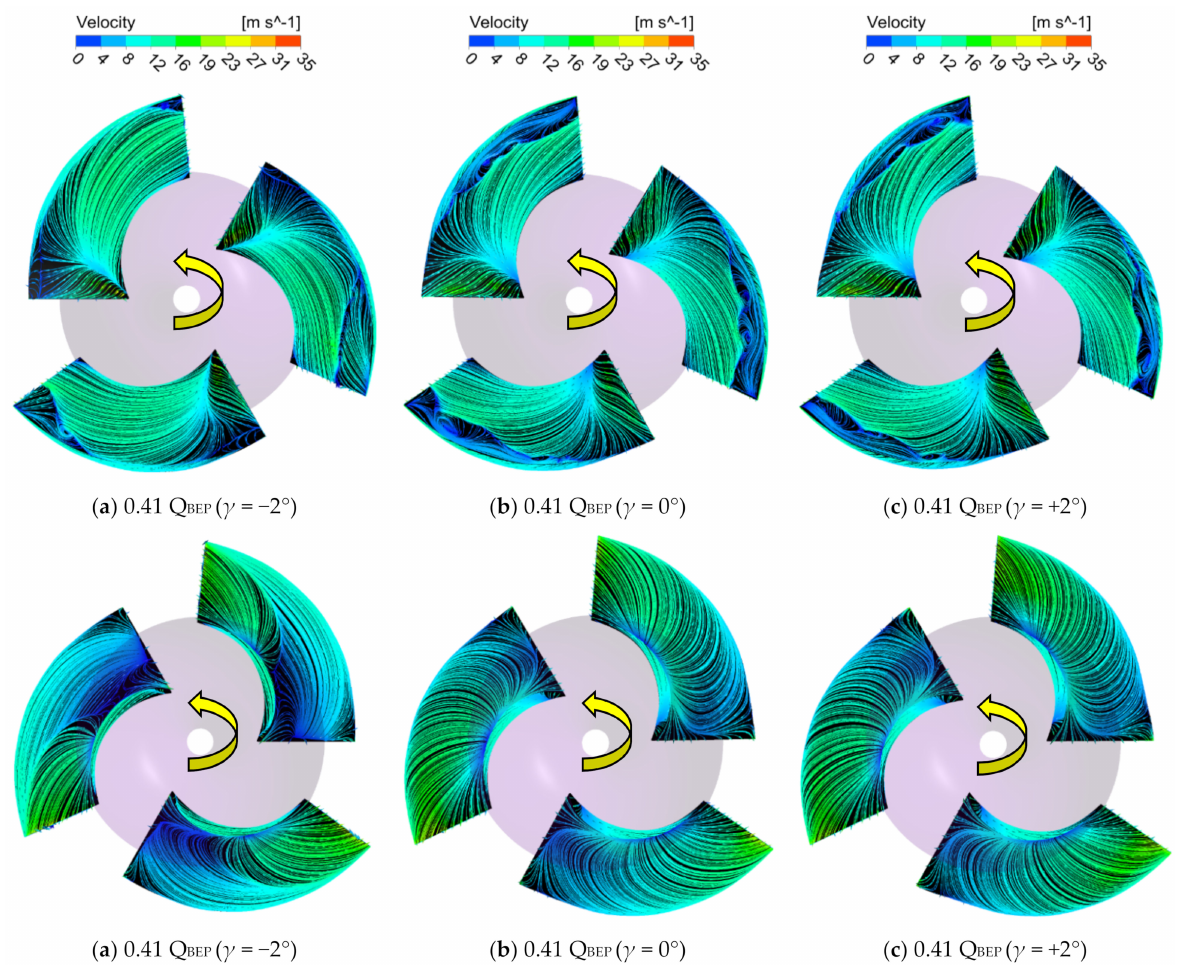
Figure 19. Streamlines colored according to velocity on runner blade’s suction ( up ) and pressure surfaces ( down ) under deep part-load flow conditions (0.41 Q BEP ) for different blade angles.